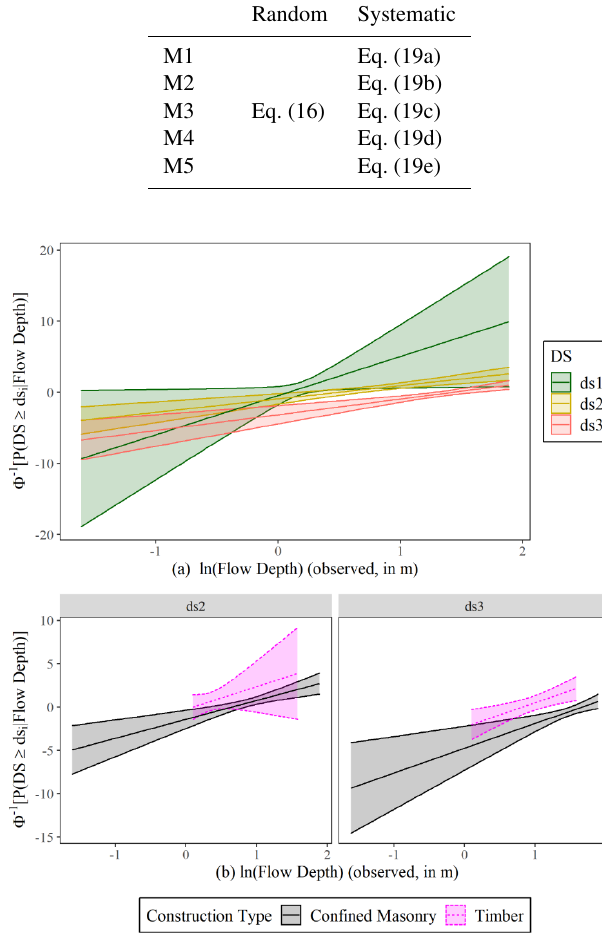
Figure 10. Probit functions fitted for each individual damage state to DB_Sunda2018 (a) to assess whether the observed flow depth is an efficient descriptor of damage and (b) to assess whether the construction type affected the shape of fragility curves for ds 2 and ds 3 . In both cases, the 90% confidence interval is